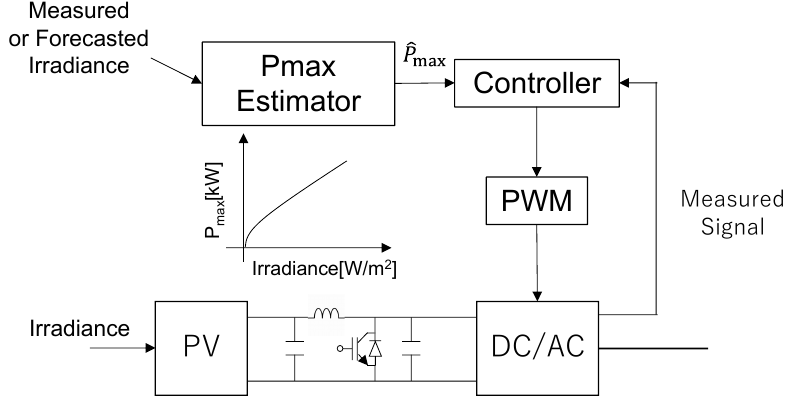
Figure 12. Scheme of the available power reserve (upper limit control) system. The headroom is estimated by the maximum power estimator, which maps the correspondence between solar irradiance and PV maximum power, and the estimate is passed to the controller to ensure stable operation of the PV-VSM.